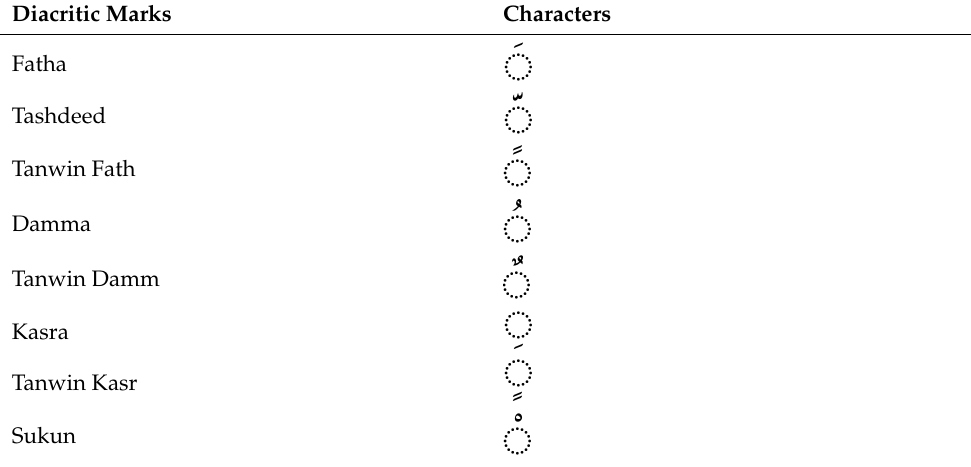
Table 3. Arabic diacritic marks.